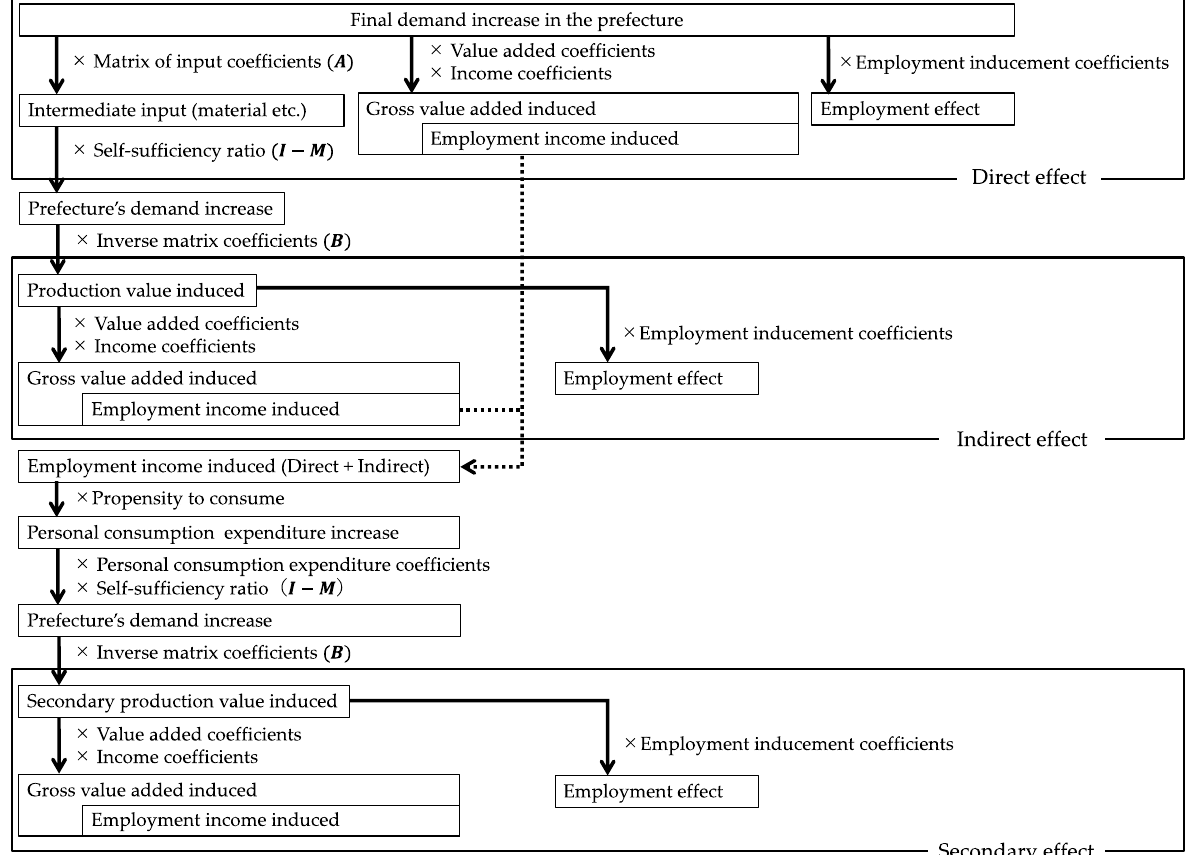
Figure 5. Procedure for evaluating economic impact.